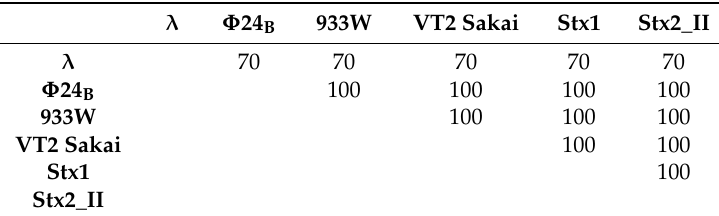
Table 5. Scores of pairwise alignments of the predicted amino acid sequences of Orf61 from six analyzed